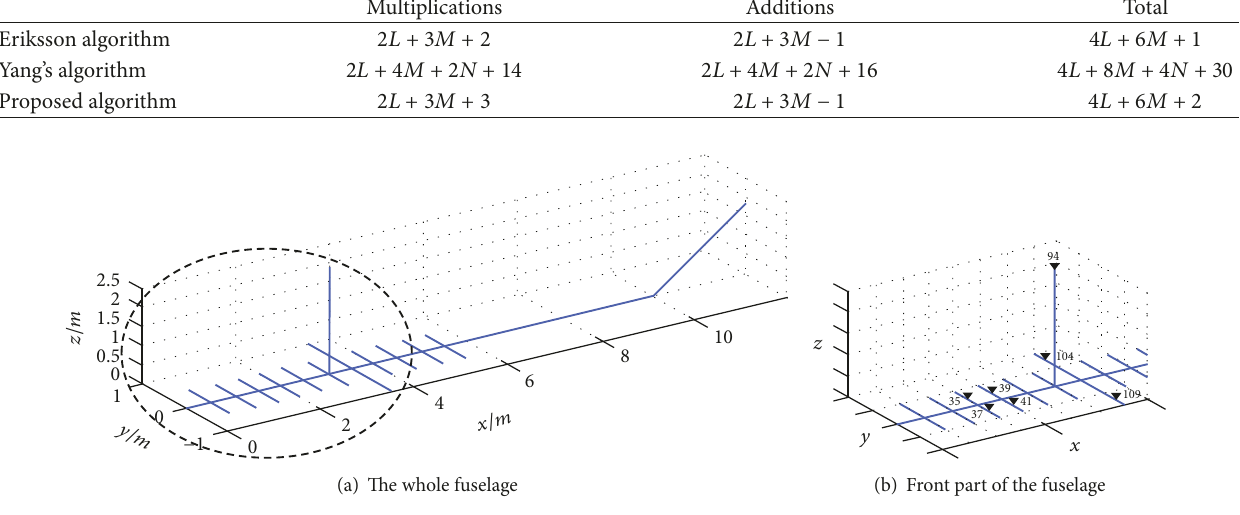
Figure 4: Simplified FEM model of helicopter.